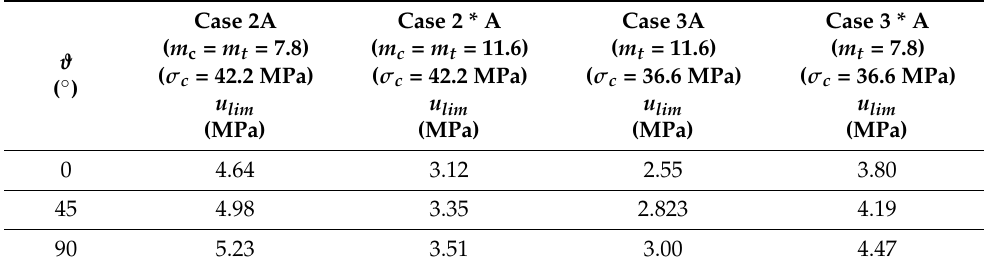
Table 3. Influence of strength parameters and limit pore pressures in Case A.